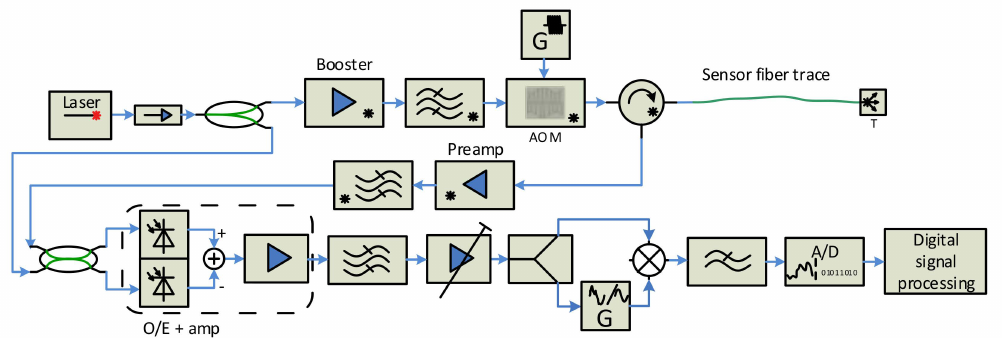
Figure 9. Final sensor unit scheme used of the test-bed.